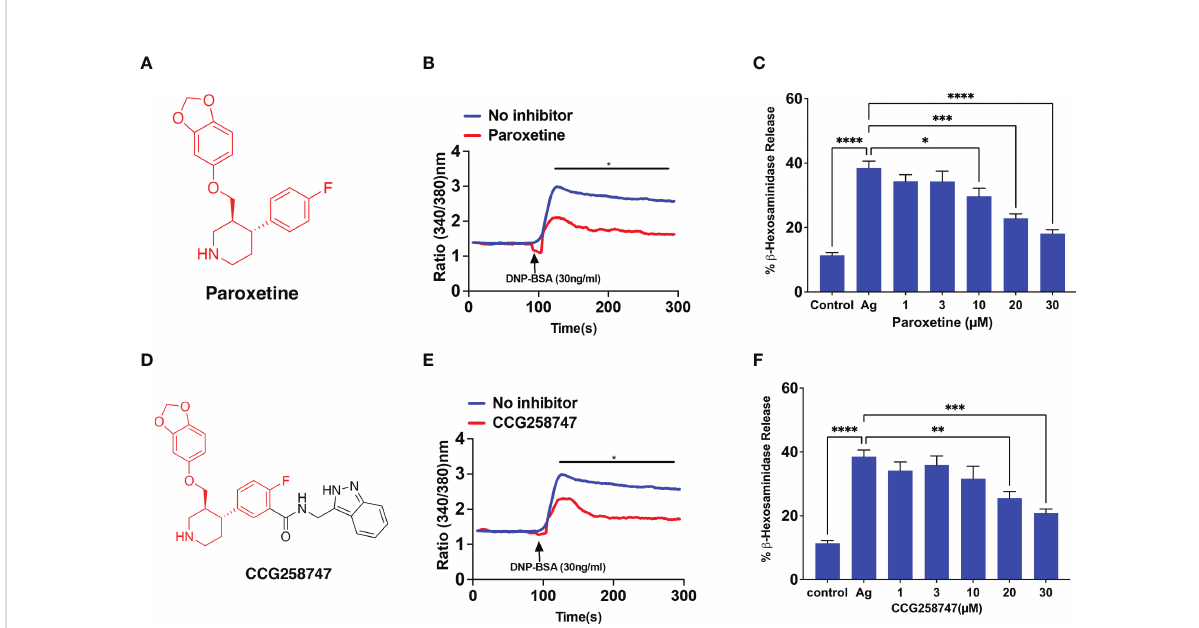
FIGURE 1 Paroxetine and CCG258747 inhibit Fc ϵ RI-mediated response in RBL-2H3 cells. (A) Structure of paroxetine. (B) Measurement of Calcium mobilization upon antigen (DNP-BSA; 30 ng/mL) stimulation with/without pre-incubation of IgE-primed RBL-cells with paroxetine (30 µM, 30 min). (C) IgE-primed RBL cells were pre-incubated with different doses of paroxetine (0-30 µM) and stimulated with antigen (Ag, 30 ng/mL) and b -hexosaminidase release was measured. (D) Structure of compound CCG258747. Measurement of antigen-induced (E) calcium mobilization and (F) b -hexosaminidase release in IgE-primed RBL-2H3 cells in the absence or presence of CCG258747. Error bars are standard error of mean (SEM) from at least three independent experiments and signi fi cant differences were set at *p ≤ 0.05, **p ≤ 0.01, ***p ≤ 0.001 and ****p ≤ 0.0001. Error bars are not displayed for (B) and (E) for clarity. For fi gure B and E, C and F, data were generated simultaneously from the same experiment with same